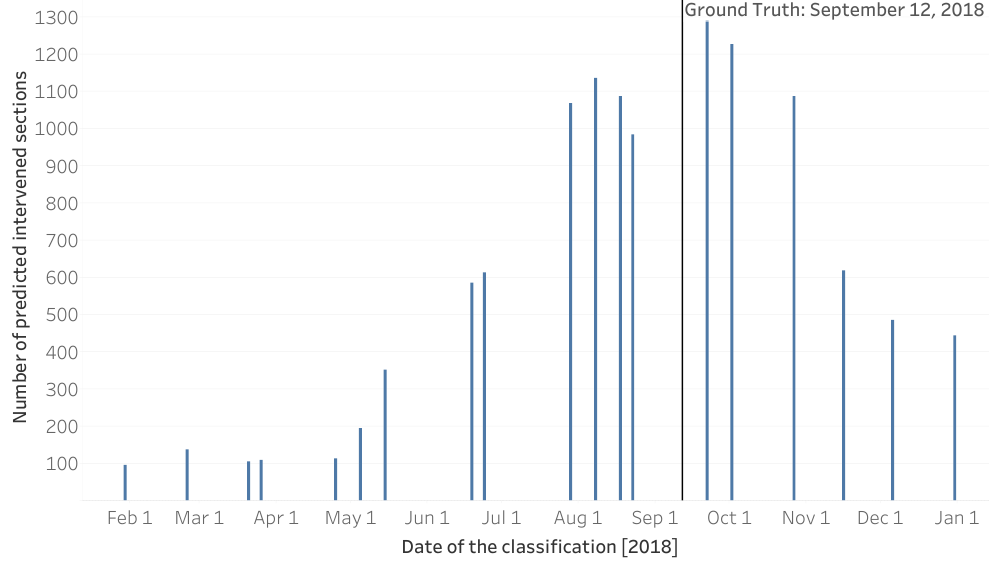
Figure 10. Number of sections classified as treated using the best model (RF with DS_ALL) along the whole year of 2018. Trained with data of 12 of